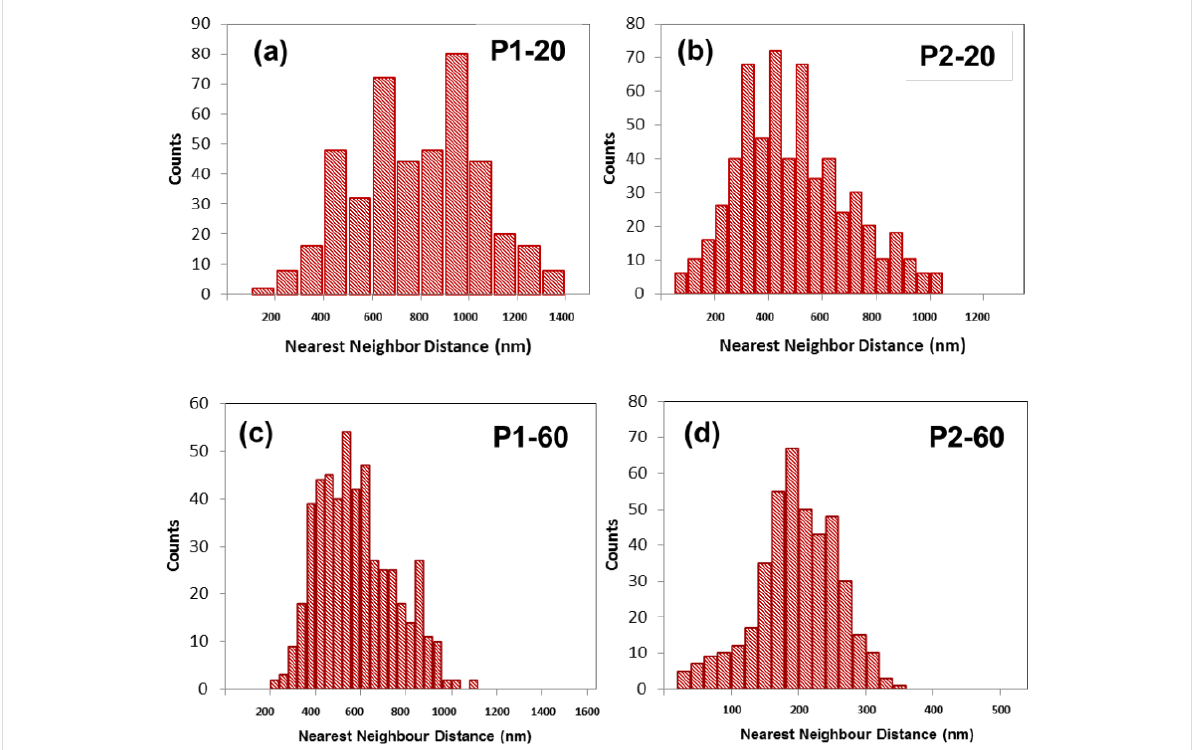
Figure 4: Histogram for the nearest-neighbour distance of gold nanoparticles formed in the (a) P1-20, (b) P2-20, (c) P1-60 and (d) P2-60 nanocom- posites by UV irradiation.